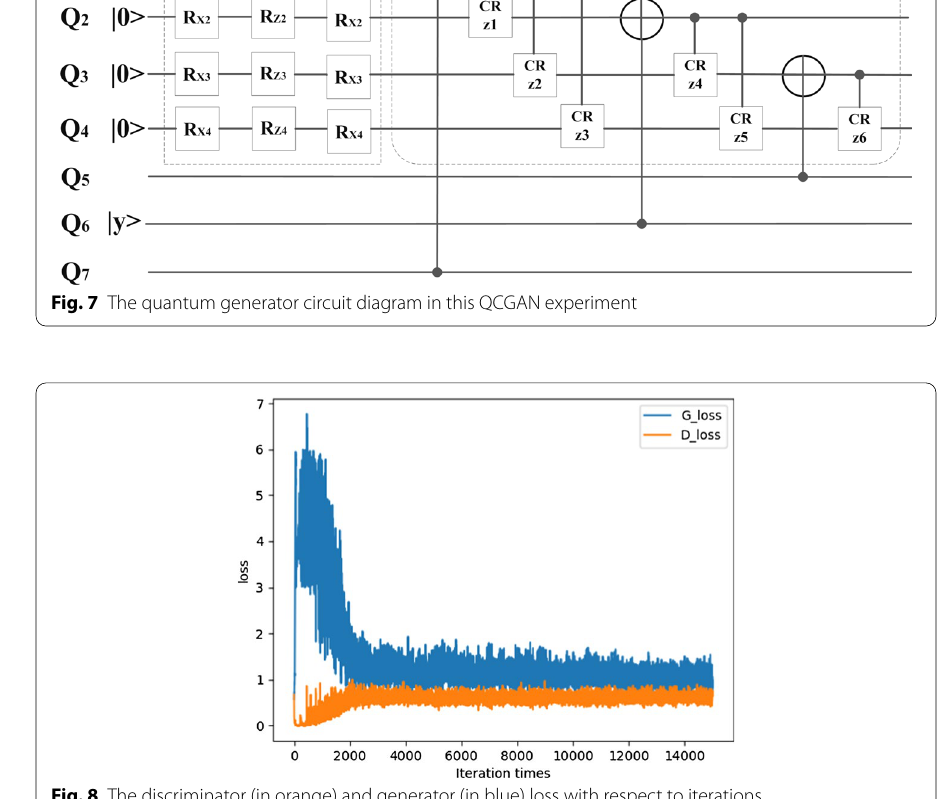
Fig. 8 The discriminator (in orange) and generator (in blue) loss with respect to